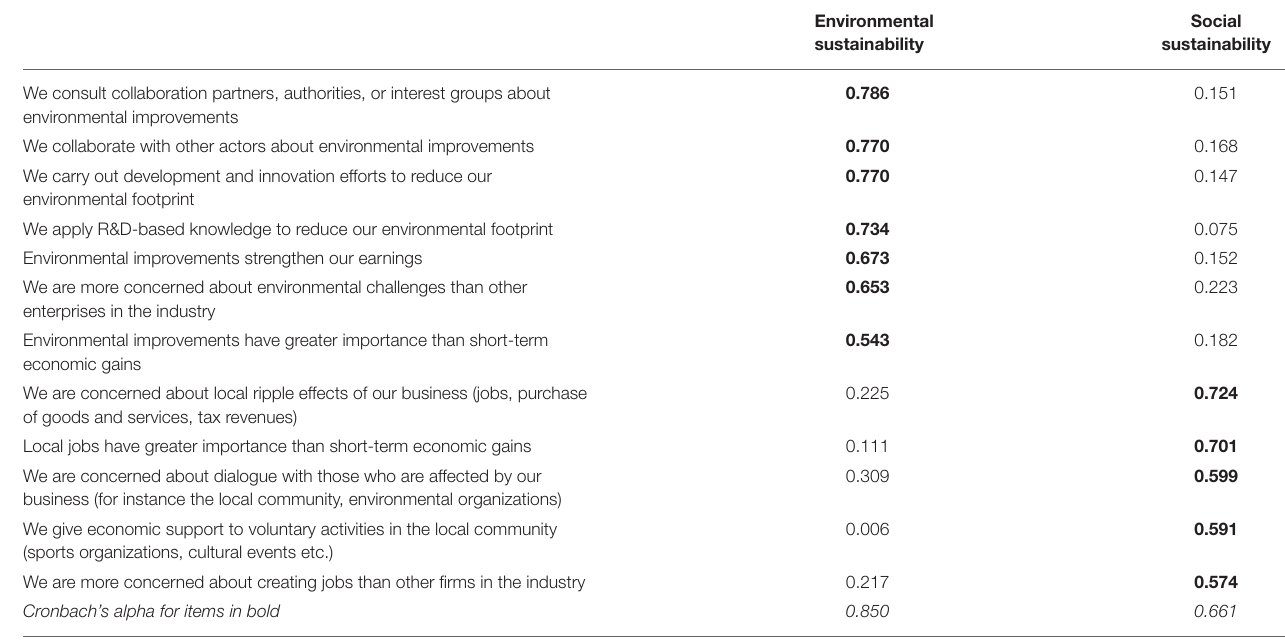
TABLE 2 | Factor analysis with orthogonal varimax